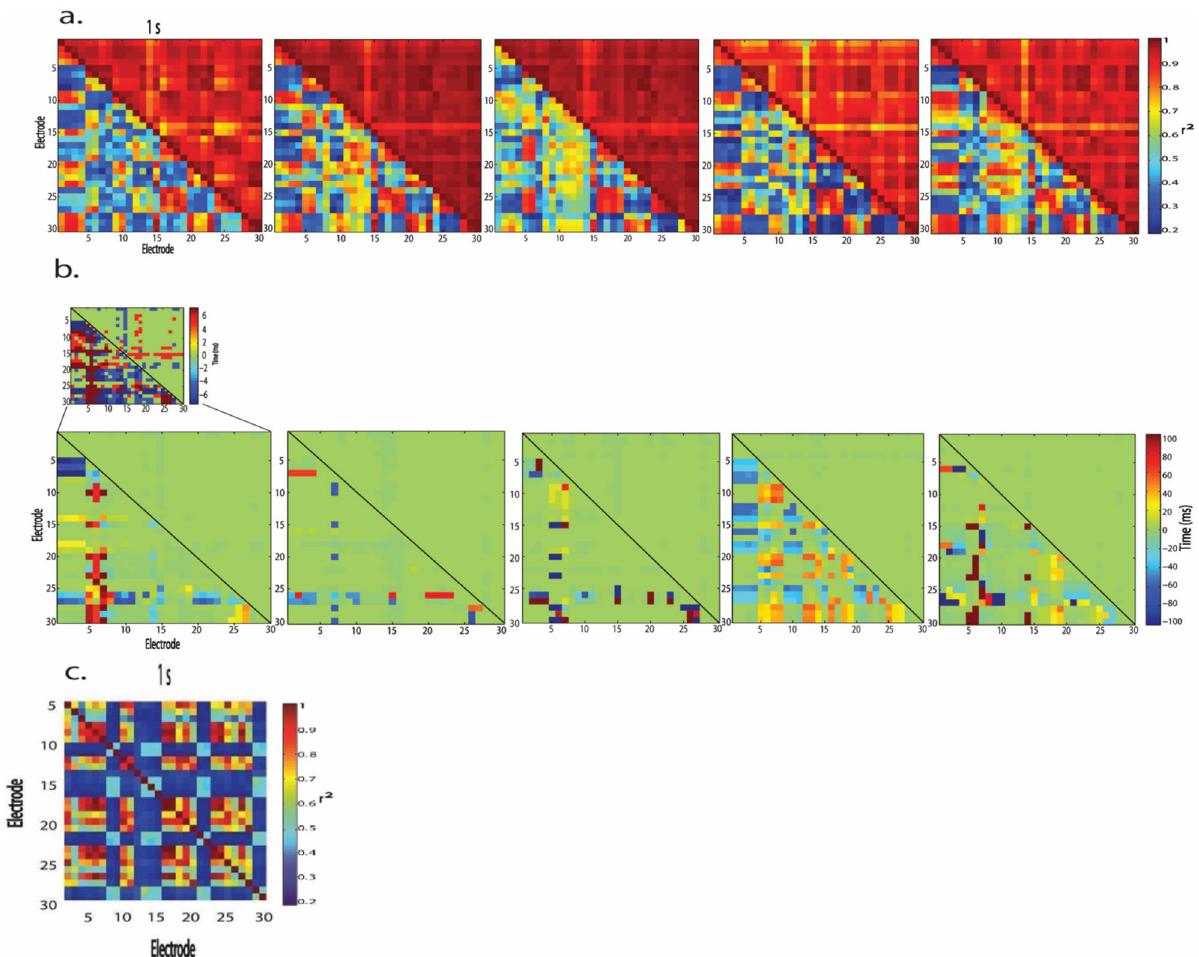
Figure 4. LFP spatial synchrony increases and corresponding time lags decrease directly after ischemic onset. ( a ) Representative LFP cross-correlograms demonstrate the overall increase in cross-correlation coefficients in 5 consecutive 1 s samples during baseline (lower triangular matrix) and within 1 min after pMCAo (upper triangular matrix) in the same animal. Cross-correlograms depict cross-correlation coefficients between each electrode and all other electrodes within the array. Cross-correlation coefficients values are increased post- pMCAo regardless of recording location. ( b ) Time lags corresponding to each r 2 value in Fig. 1a (baseline in lower triangular matrix and post pMCAo in the upper triangular matrix) show that maximal correlations occur with reduced time lag after ischemic onset. Note, the color scale of time is different between the top and bottom panels of b. The bottom panel in b represents the possible range of time lags whereas the top panel in b represents time lags zoomed in, demonstrating variability in short time lags after pMCAo. ( c ) A representative surgical control cross-correlogram of LFP is depicted from 1 s before (lower left) and after (upper right) baseline in a surgical sham animal demonstrate a range of cross-correlation coefficients between electrode pairs in a healthy cortex. Cross-correlograms illustrate cross-correlation coefficients of each electrode in the electrode array. In surgical sham animals, low and high cross-correlation coefficients were observed throughout recordings. Electrodes with consistent noise were excluded from this representative sample and all activity patterning (Fig. 6a, red box) consistent with Fig. 3. Neuronal activity during power bursts were not epileptiform as is noticeable by the LFP represented in Fig. 6e. Power bursts occurred for approximately 1 or more seconds and were more prominent at lower frequencies, including but not limited to delta band frequen- cies (Figs. 6c, 7). The presence of multi-frequency power bursts minutes to an hour after pMCAo indicates their persistence during the acute post pMCAo period. Additionally, lower bursts withstood normalization at acute post pMCAo timepoints (Fig. 7). Isolated power bursts underlie acute post pMCAo spatiotemporal synchrony.